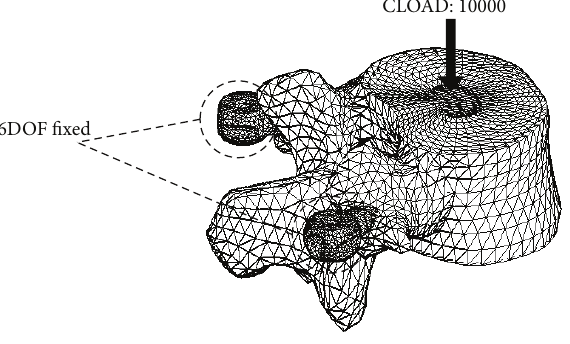
Figure 15: Boundary and load condition for evaluation.